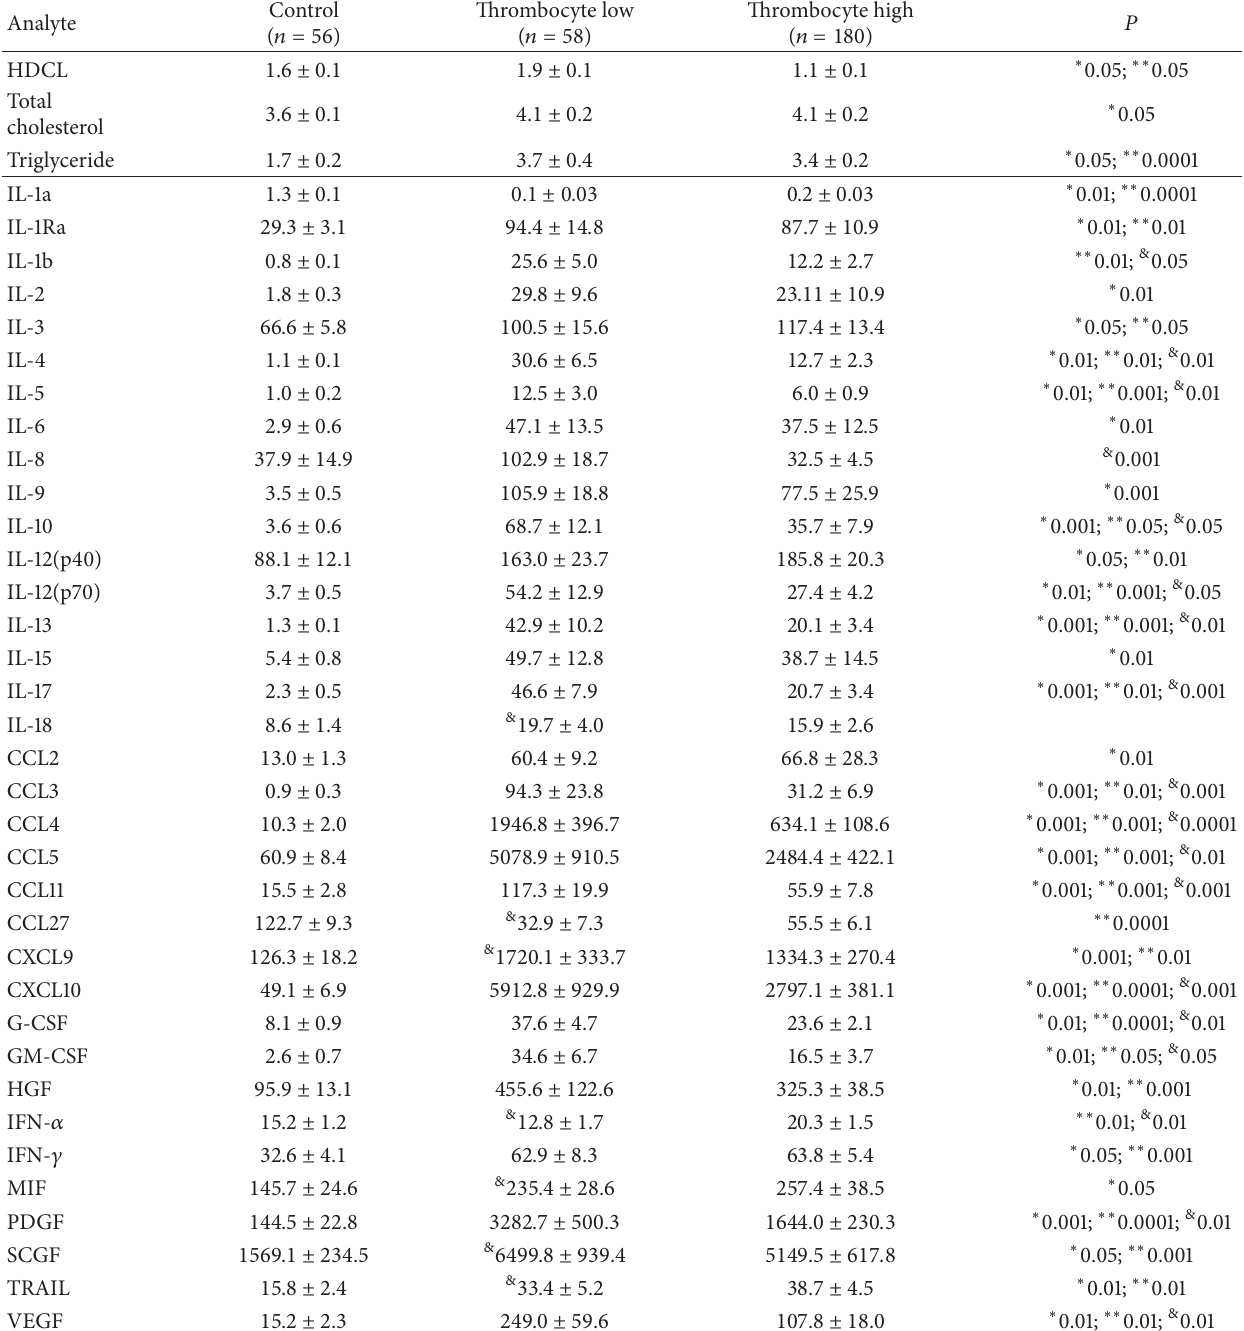
Table 7: Lipids (mmol/L) and cytokine (pg/mL) analysis based on thrombocytes ( × 1000 cells/ 𝜇 L) counts (low < 50.000 versus high >